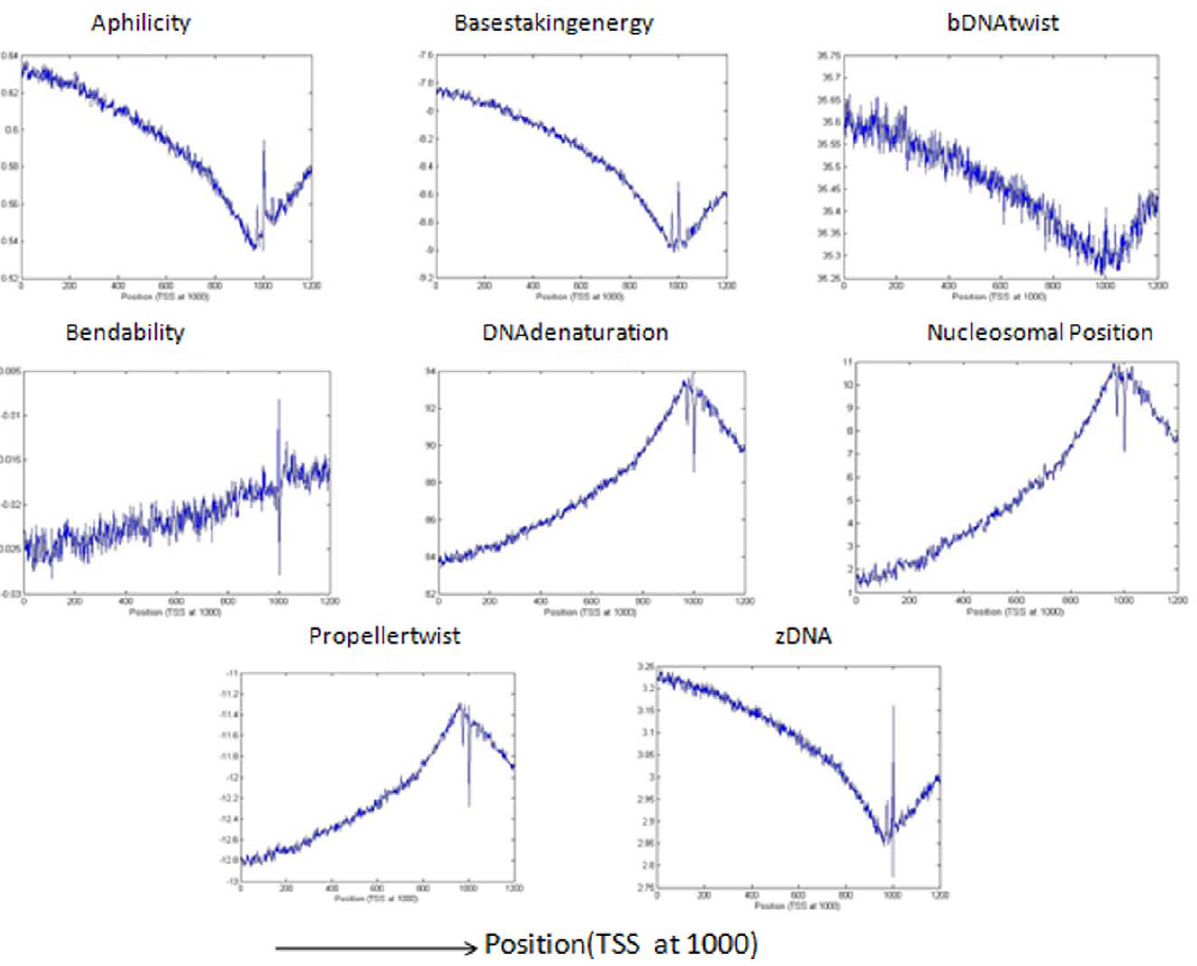
Figure 2. Structural pattern of eight different features for the sequences taken from UCSC table browser of hg19 human genome. The sequences used here are generated by grammars i.e. predicted as true promoter. The structural profiles are plotted with average value of window size 3 nt.